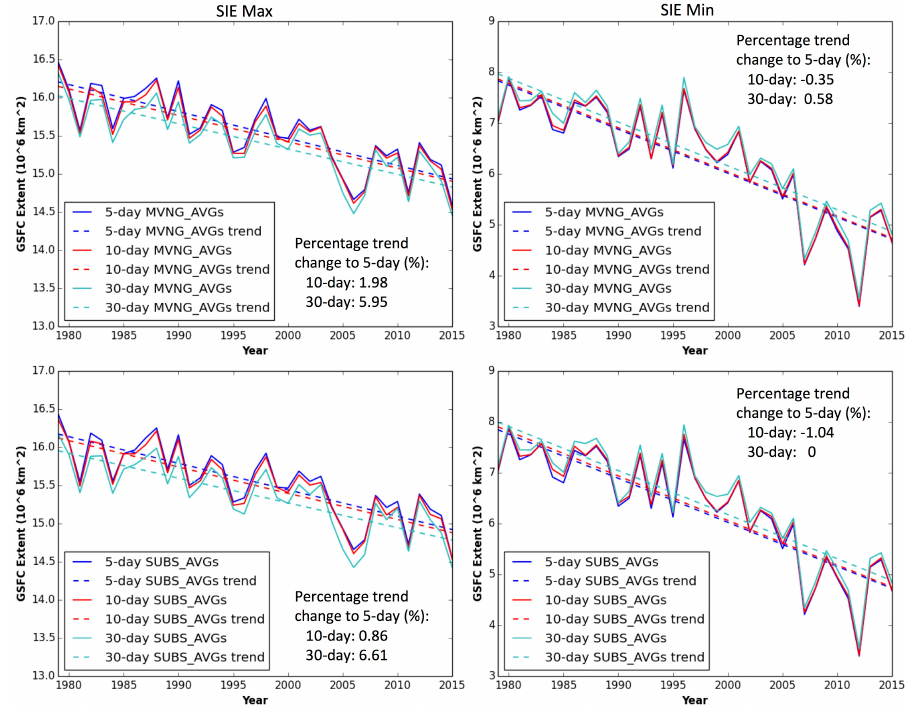
Figure 2. Time series (solid) of annual Arctic SIE maximums (left panels) and minimums (right panels) and their linear trends (dashed) for moving average (top two panels) and subsetting average (bottom two panels) methods for different averaging intervals (5-, 10-, and 30-day). The percentage changes of decadal trends from the 10- and 30-day averages relative to that from the five-day averages are displayed.